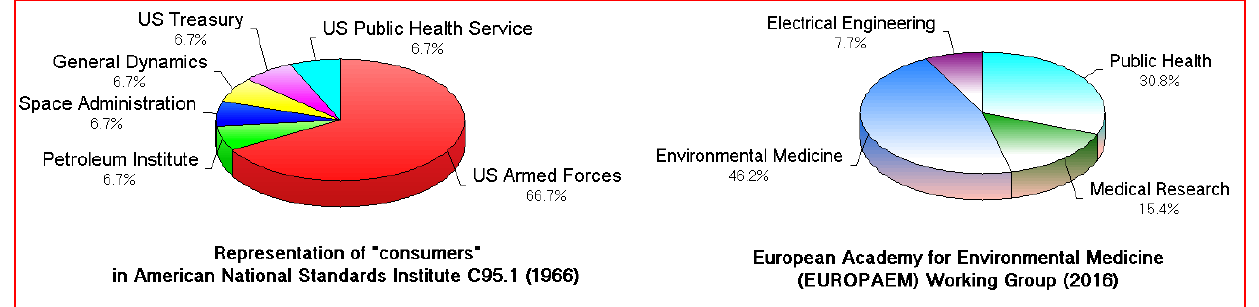
Figure 2. Task forces assessing biological impacts of RFR in 1966 (IEEE) at left, and EUROPAEM, 50 years later, at right.